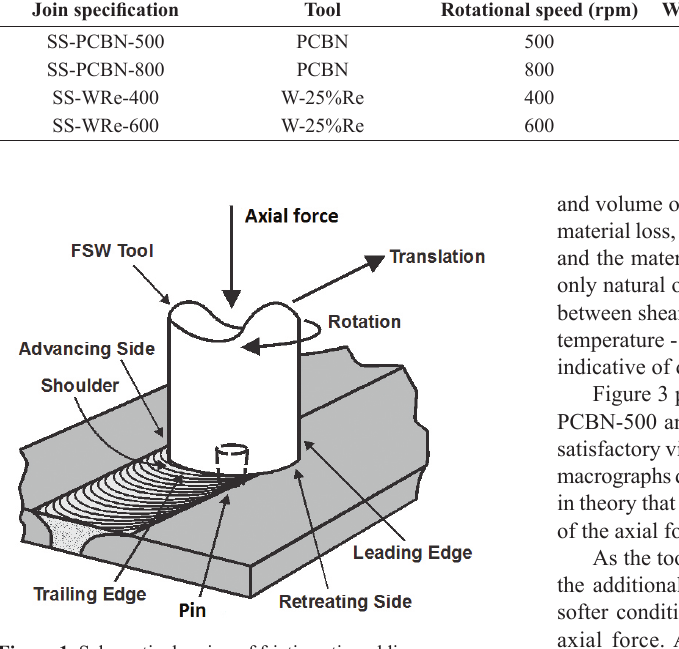
Figure 1. Schematic drawing of friction stir